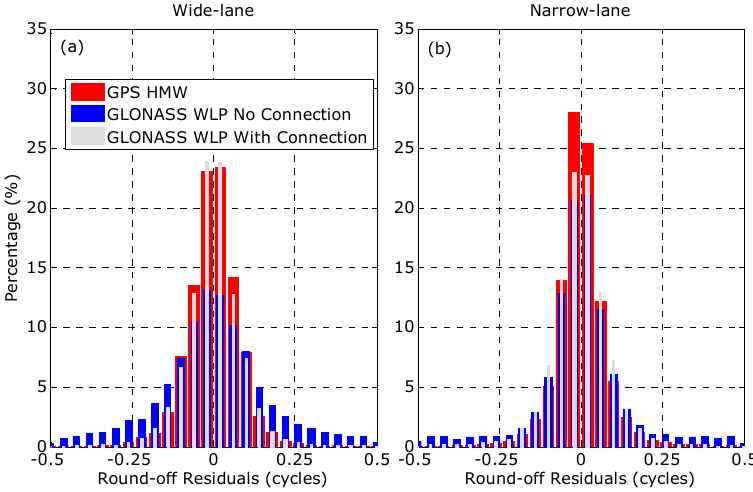
Figure 5. Distributions of the a posteriori residuals in GPS and GLONASS wide- and narrow-lane SDBR ambiguities fixing using the HMW and the WLP (wide-lane phase) combinations. ( a ) It shows the distributions of the a posteriori residuals of the wide-lane ambiguities; ( b ) It shows the distributions of the a posteriori residuals of the narrow-lane ambiguities.